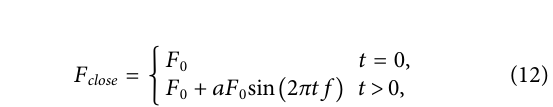
Frontiers in Energy Research |